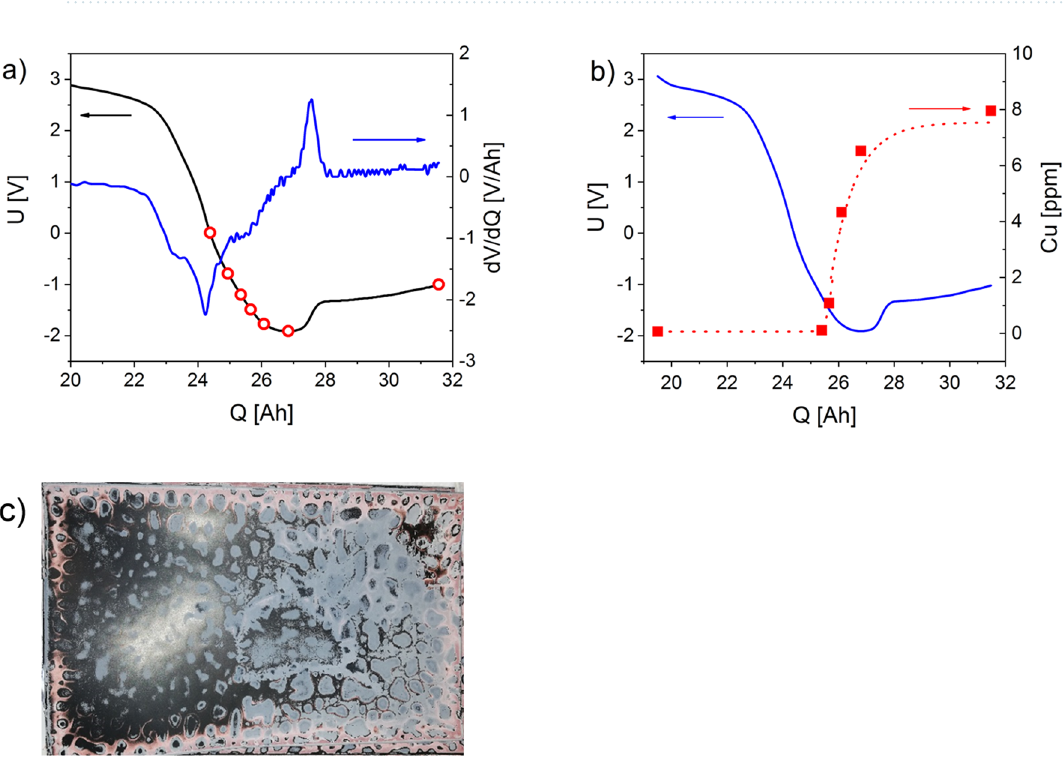
Figure 3. ( a ) Complete discharge curve of a cell during overdischarge at 58 mΩ; markers show the points at which the discharge was stopped and the electrolyte was removed; ( b ) voltage curve of the cells during overdischarge; red dots show the copper concentration in the electrolyte; ( c ) cathode foil with copper deposition (Q = 31.5